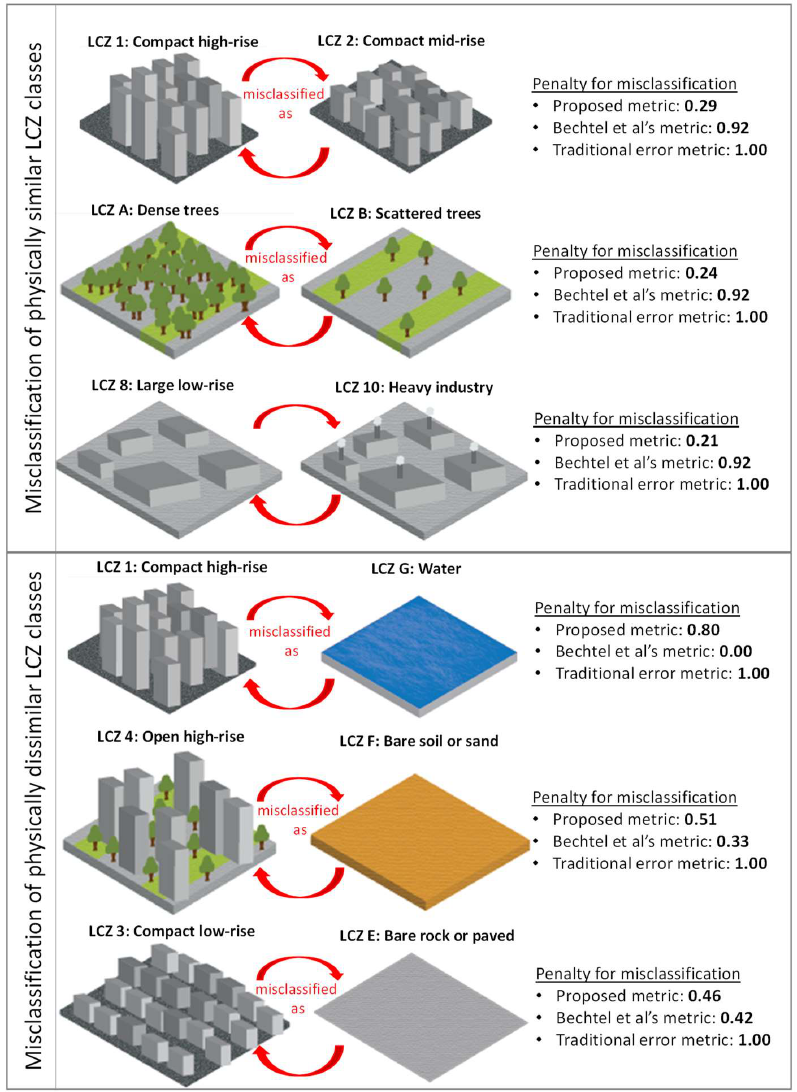
Figure 2. Comparison of misclassification penalties derived using our proposed LCZ dissimilarity metric, the metric proposed by Bechtel et al. [18], and the traditional error metric (i.e., equal penalty applied to all types of misclassifications).